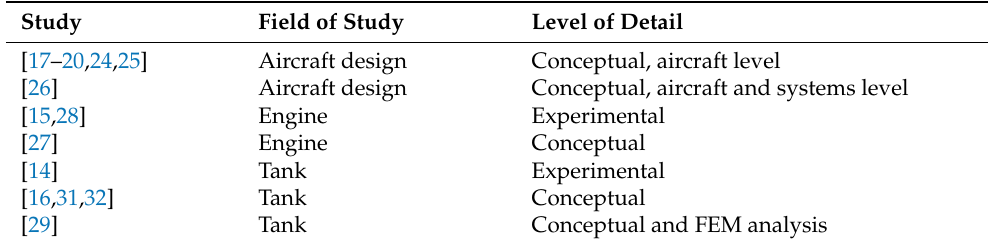
Table 2. Level of detail of most relevant studies reported in state-of-the-art analyses.